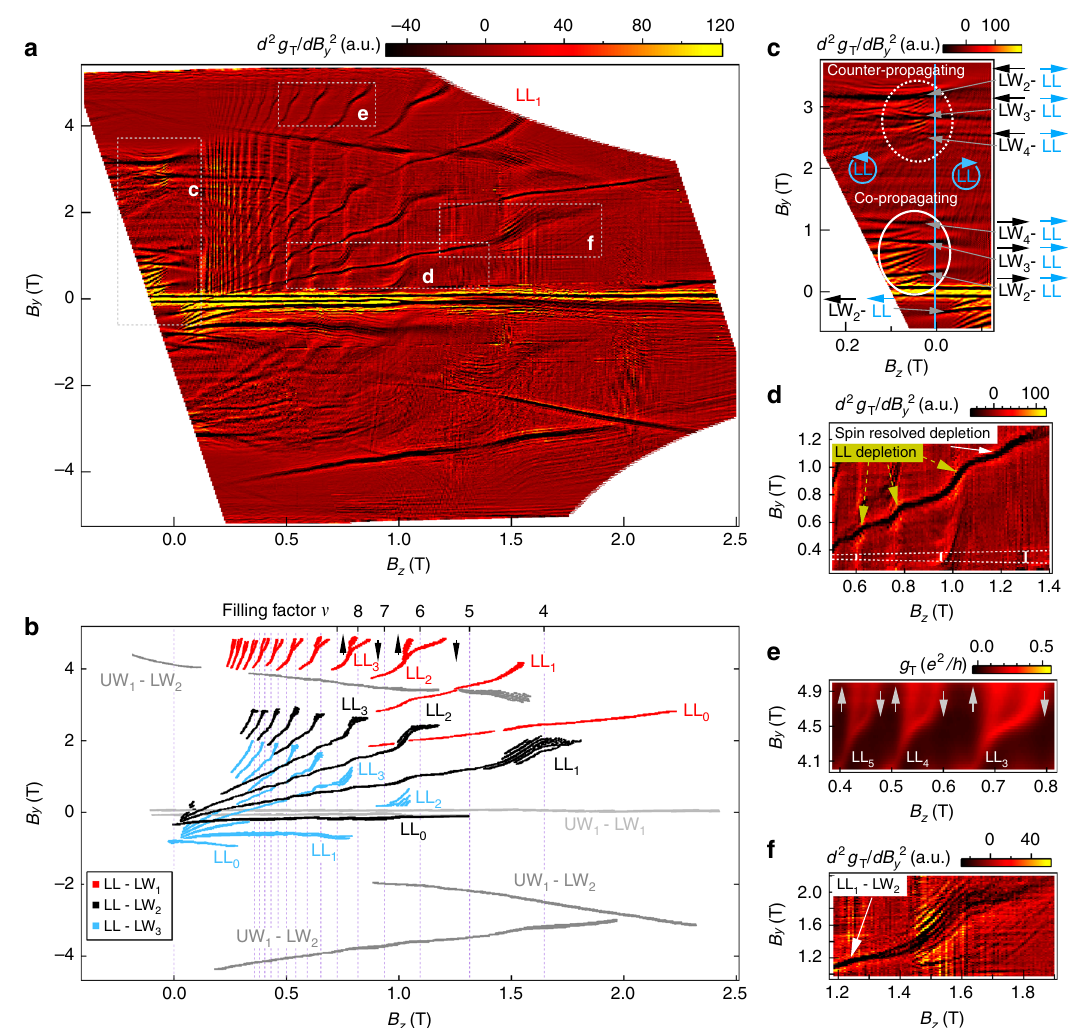
Fig. 3 Magnetic depopulation and spin splitting of integer quantum Hall edge states. a Second derivative with respect to B y of the differential tunnel = dB 2 conductance d 2 g T